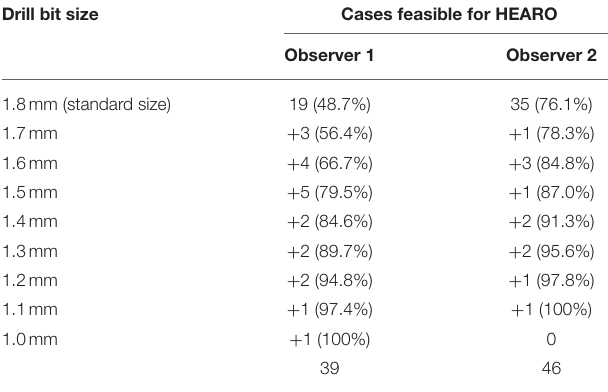
TABLE 3 | Success rate of planning a safe trajectory for the HEARO